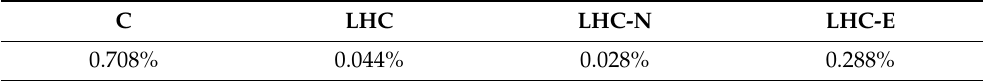
Table 4. Comparison of the coke deposition through a 3-cycle (56 h/cycle) oil heating test. C